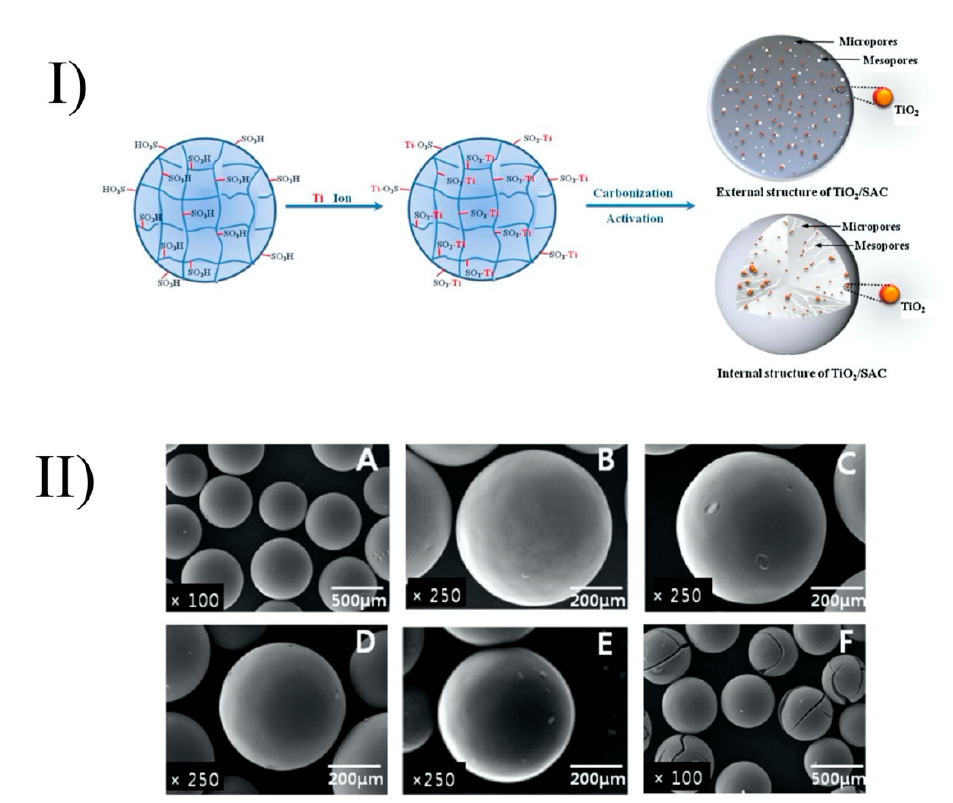
Figure 4. Formation of TiO 2 / SAC spheres ( I ) and their surfaces after heat treatment ( II ) at di ff erent temperatures: strong acid ion exchange resin ( A ), TiO 2 / SAC-700 ( B ), TiO 2 / SAC-900–0.5 ( C ), TiO 2 / SAC-900-2 ( D ), TiO 2 / SAC-900-6 ( E ), and TiO 2 / SAC-900-9 ( F ). Reprinted with permission from [70]. Copyright 2013, Elsevier.